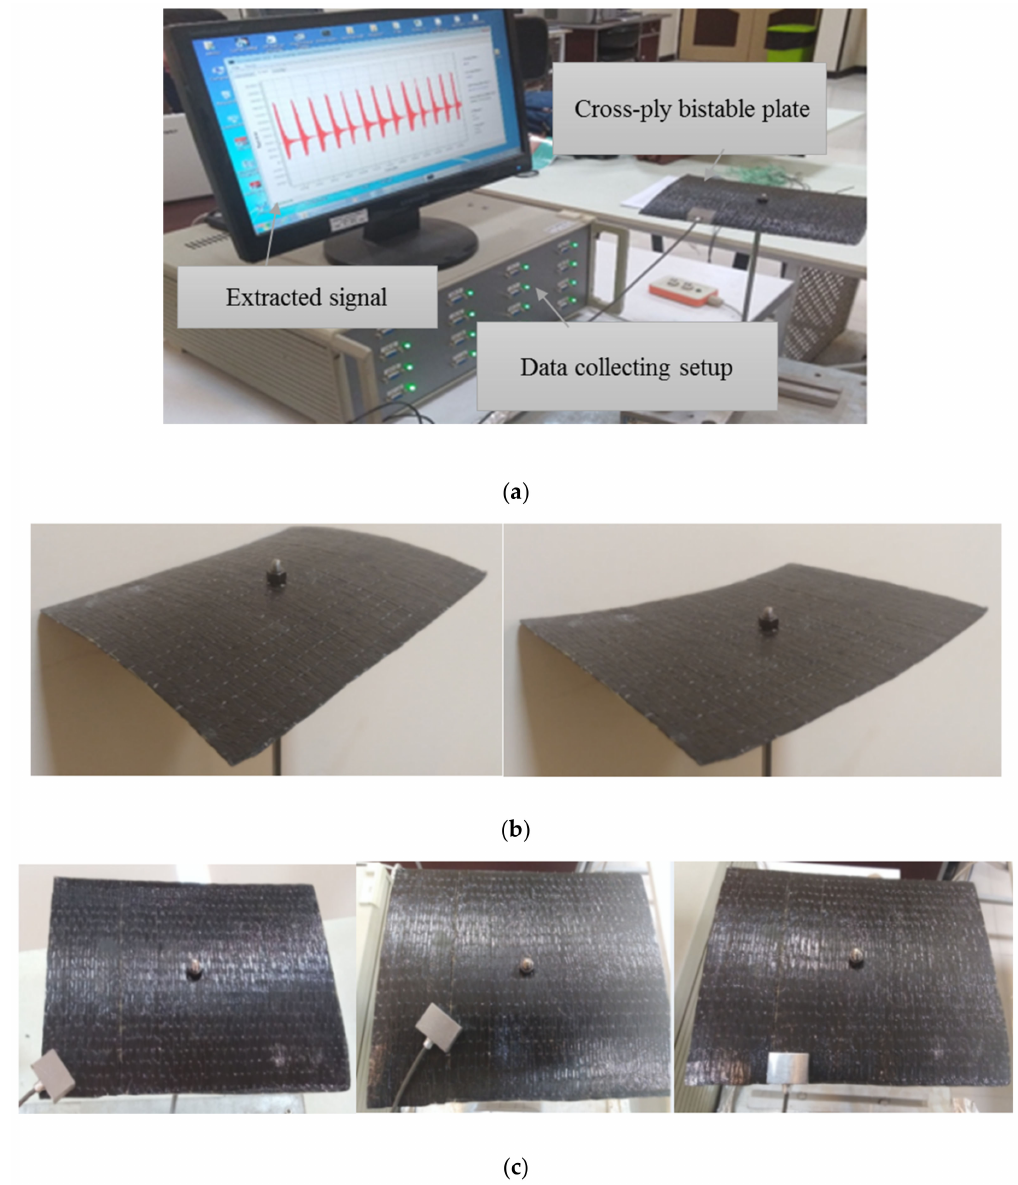
Figure 6. Experimental method to collect the desired signal from the vibrational response of a bistable composite plate: ( a ) the used set up, ( b ) the two stable shapes of the bistable laminate, and ( c ) an appropriate sensor in different points of the